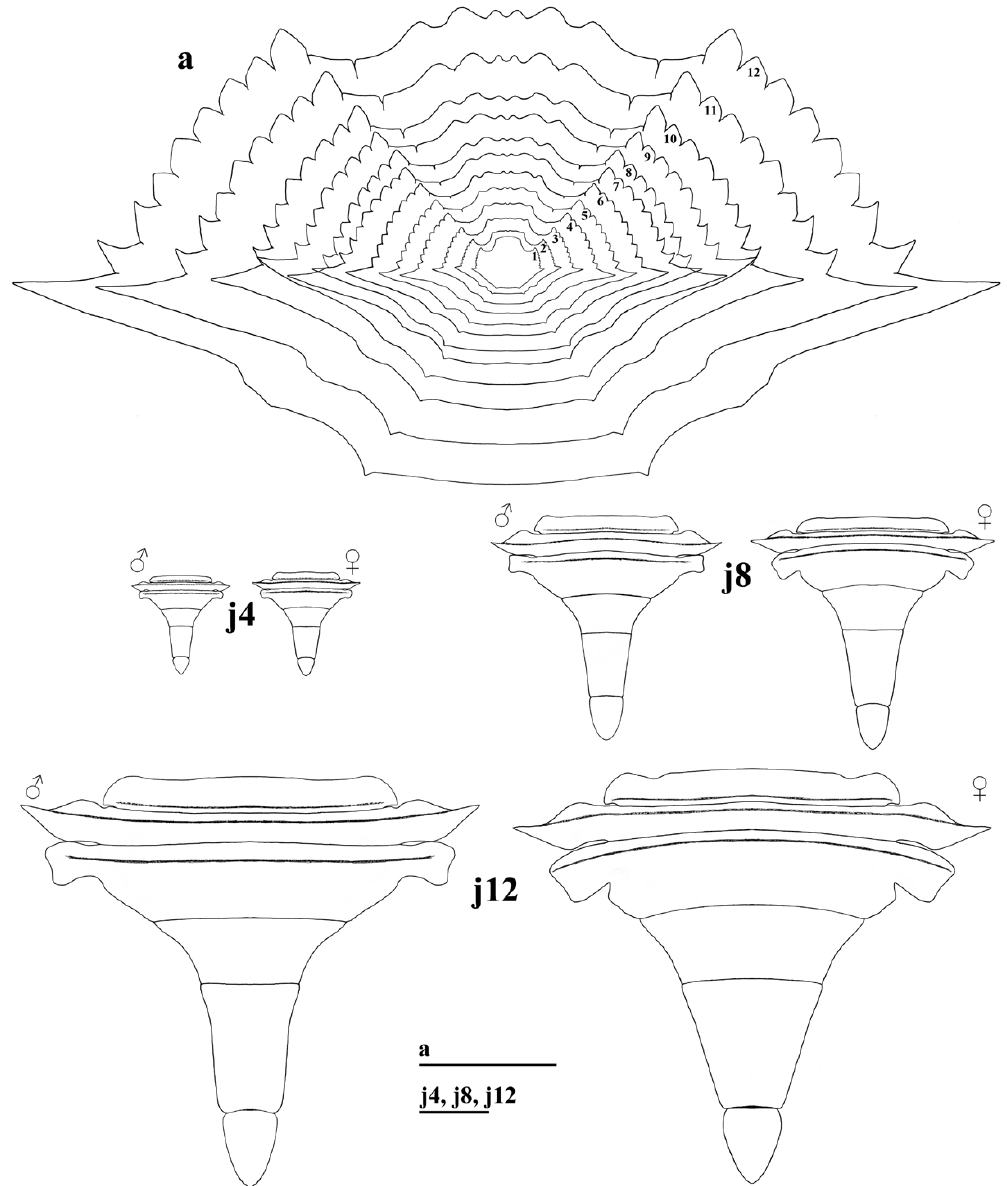
Figure 5 - Callinectes danae . A , carapace development throughout all juvenile stages obtained (numbers represent the stage of the juvenile phase); j4 , j8 and j12 , development of the abdomen shape of both males and females in 4 th , 8 th and 12 th stages, respectively. Scale: A , 5mm; j4 - j12 ,